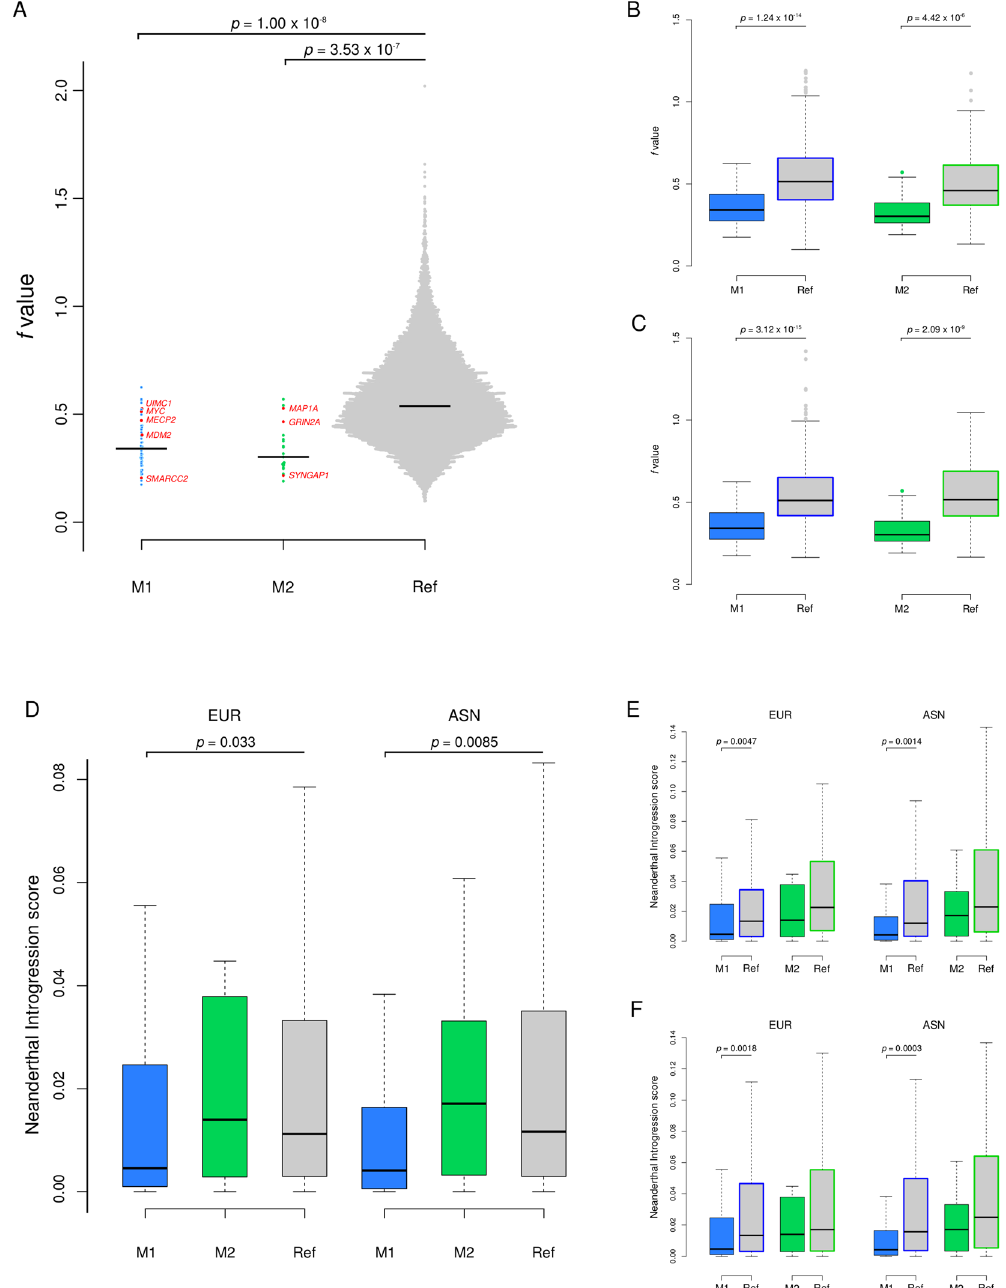
Figure 5. Degree of selective constraints and Neanderthal ancestry of M1 and M2 genes. ( A ) Swarm plot representation of f values for M1 (blue), M2 (green), and all other human RefSeq genes (Supplementary Table S5). Tukey’s post-hoc test p values are reported. Genes showing evidence of positive selection in the mammalian phylogeny are in red. ( B ) Boxplot representation of f values for M1 and M2 genes compared to gene sets matched for GC content and length (M1 reference set (blue border) = 1344 genes, M2 reference set (green border) = 84 genes) or ( C ) GERP score (M1 reference set (blue border) = 649 genes, M2 reference set (green border) = 126 genes). Student’s t test p values are reported. ( D ) Comparison of the average introgression score in European (EUR) and East Asian (ASN) population for M1, M2 and all RefSeq genes. Nemenyi’s post-hoc test p values are reported. ( E ) Comparison of average introgression scores between M1/M2 genes and gene sets matched by GC content and length or ( F ) GERP scores. Wilcoxon Rank-Sum test p values are